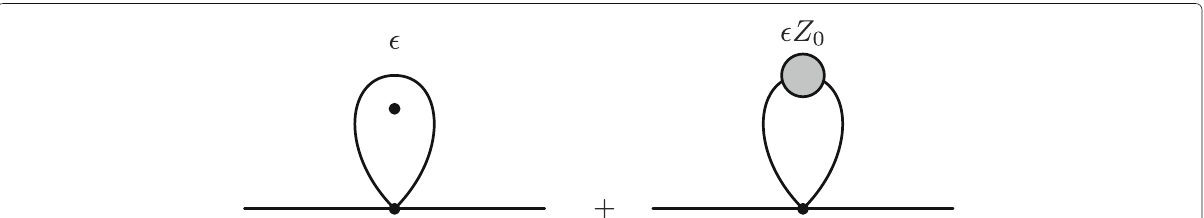
Fig. 2 Two-point functions at O ((cid:4)λ) . The left diagram has an O ((cid:4)) propagator circling the conical singularity (or the 2d brane) denoted by the dot. The right diagram has one insertion of the Z 0 coupling